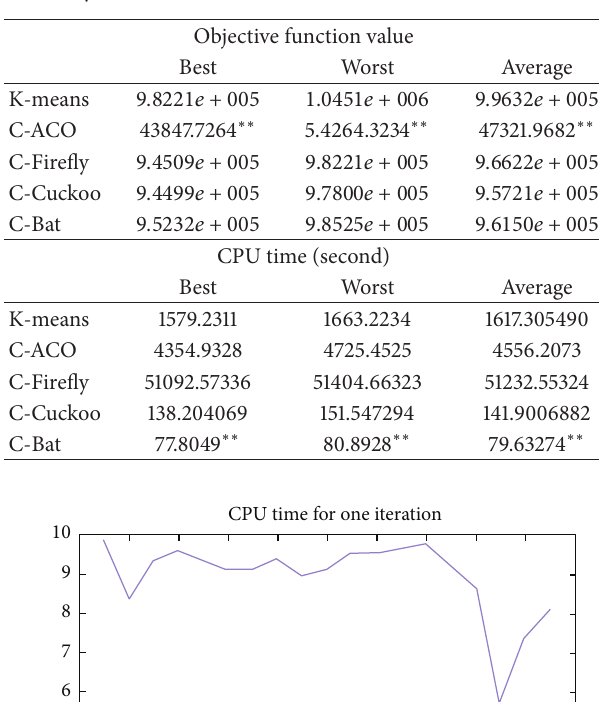
Table 11: Testing objective function fitness and CPU time consump- tion on Synthetic.